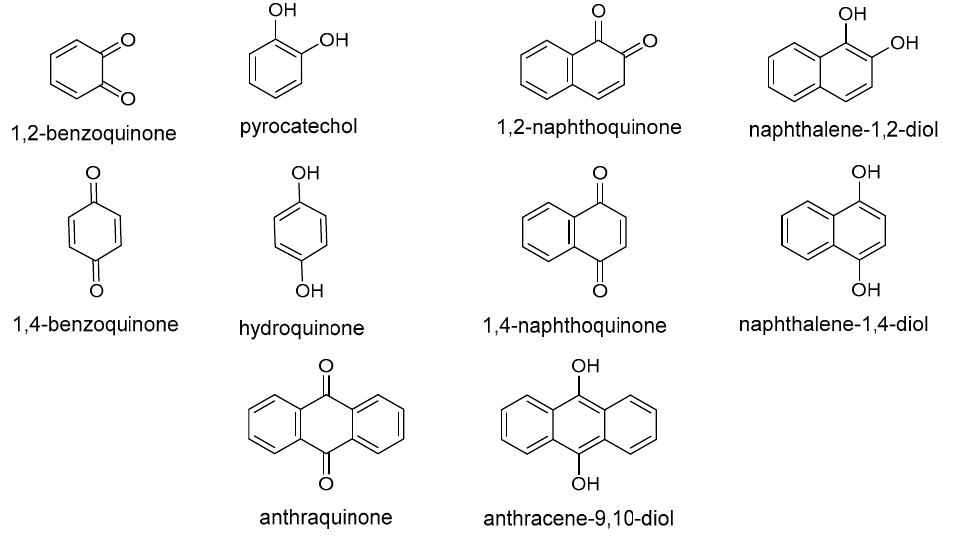
Figure 1. Quinone classification and related reduced forms.